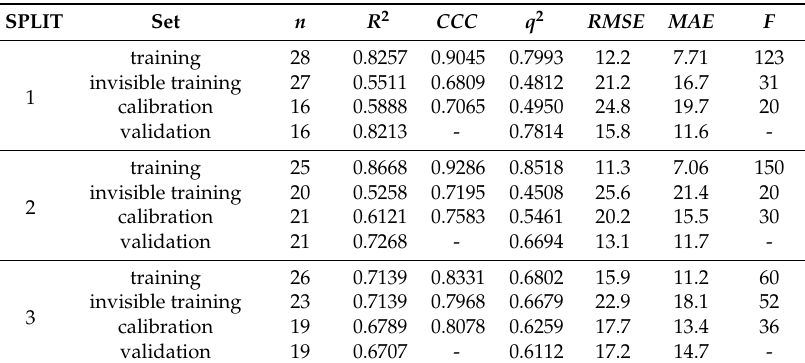
Table 3. The statistical characteristics of developed